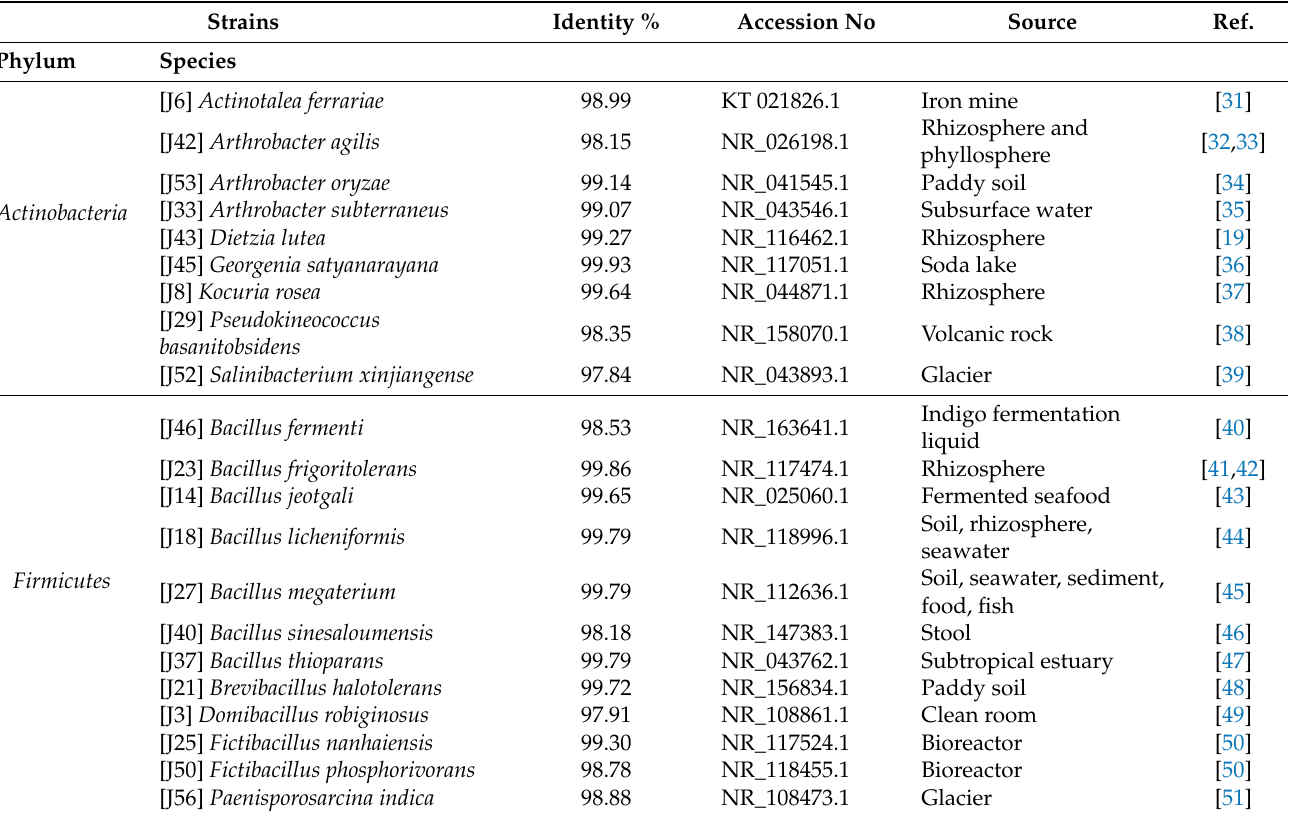
Table 1. Endophytic bacteria isolated from Z. dumosum petioles. Identity code of each endophyte is given in square brackets. Identity was based on blast analysis of their corresponding 16S rRNA encoding